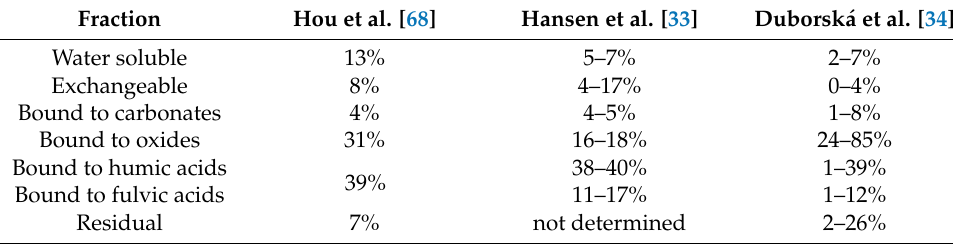
Table 1. Distribution of iodine in each soil